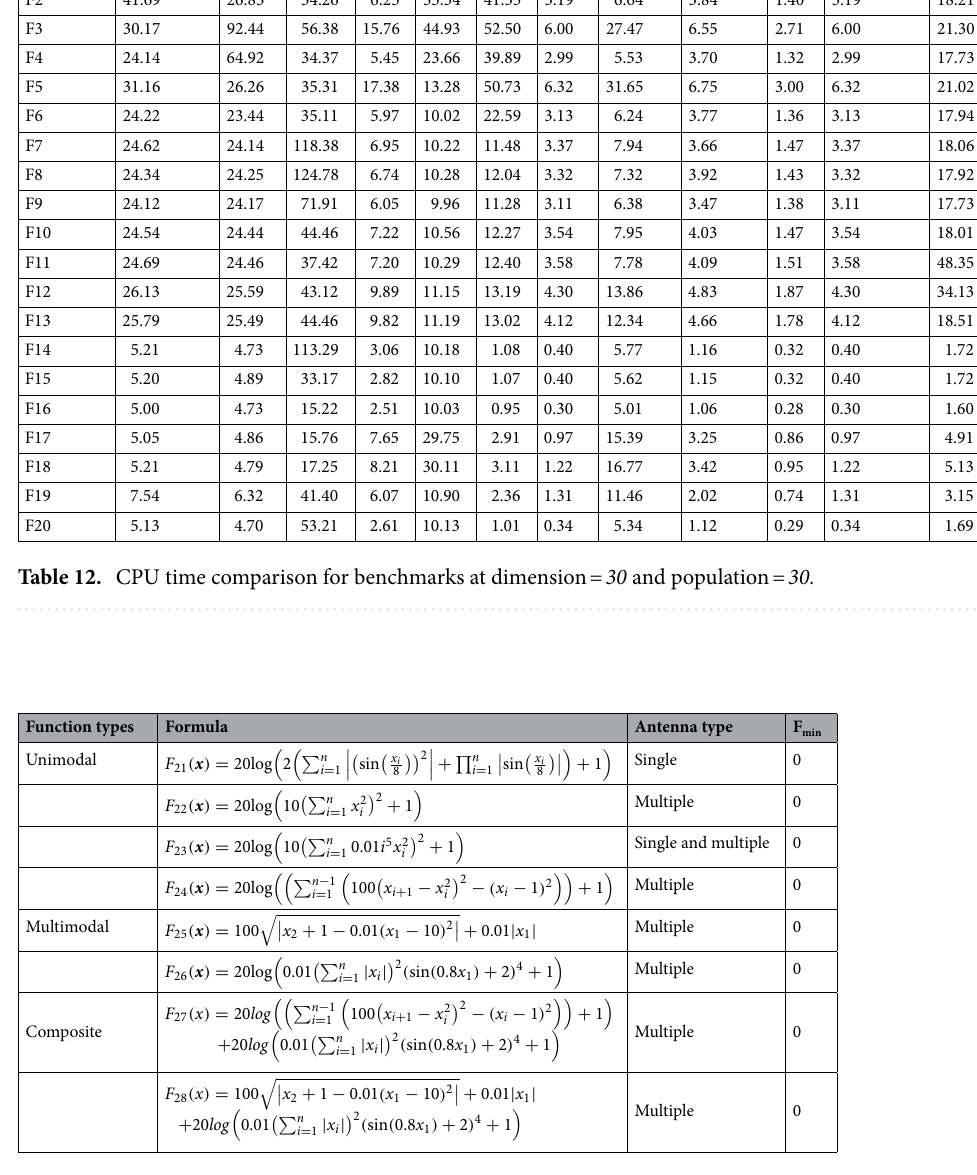
Table 13. Test functions for antenna S-parameter